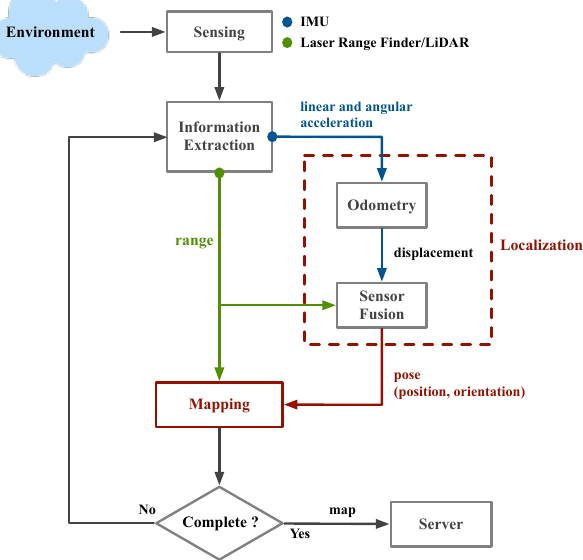
Figure 6. The on-line and real-time SLAM and object detection is illustrated in Figure 7.